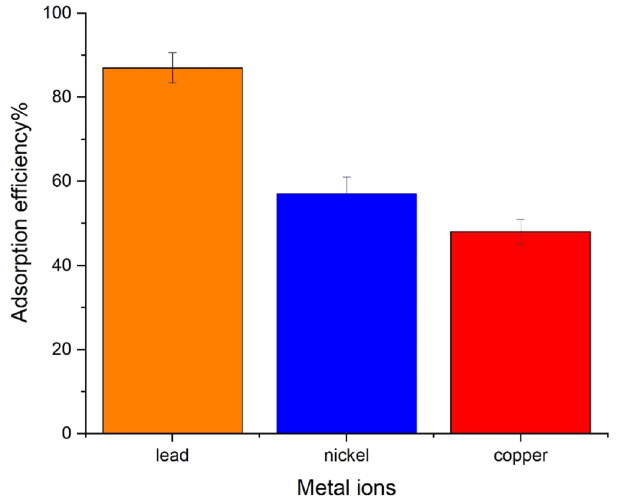
Figure 6. UAS MIL-53(Al) adsorption efficiency in removal of different heavy metal ions (20 ppm of intended heavy metal, 0.03 g UAS MIL-53(Al), and 40 ml solution, 298 K temperature).